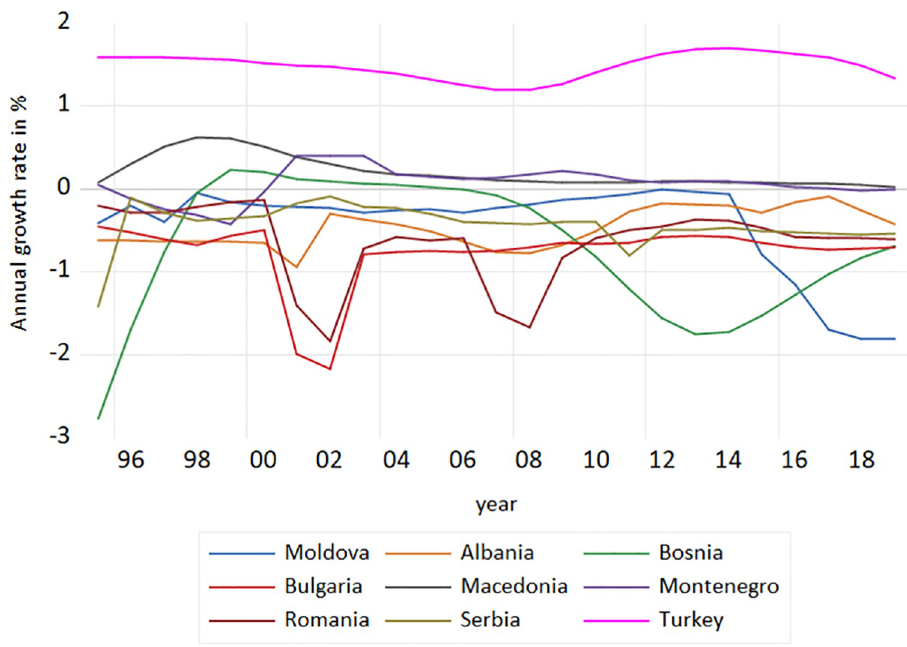
Fig 4. Population growth rate in the European middle income countries, 1995–2019. Source: Author’s design based on World Bank and UN data.